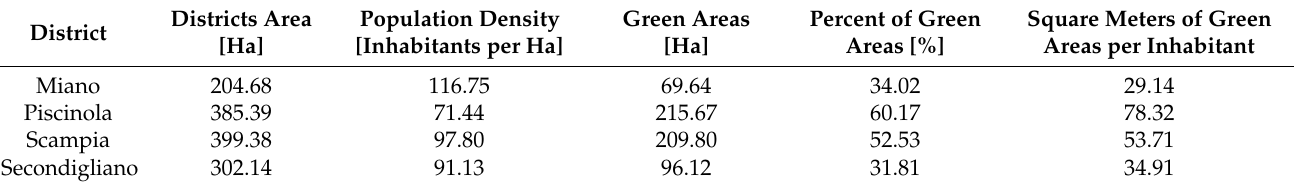
Table 1. Main characteristics of the four districts.